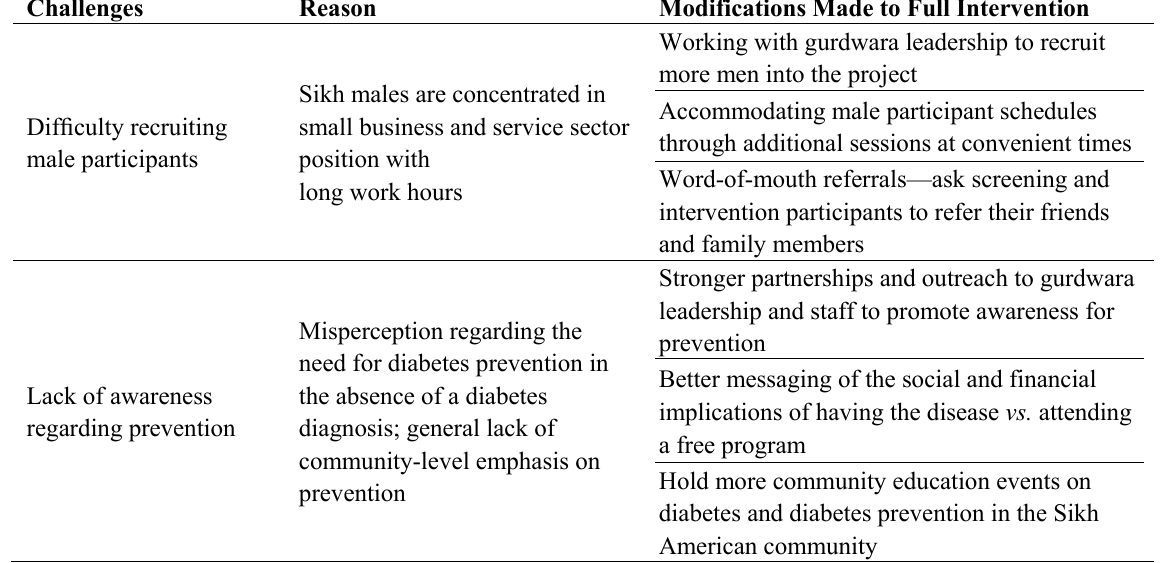
Table 6. Challenges experienced during pilot and modifications made to the full